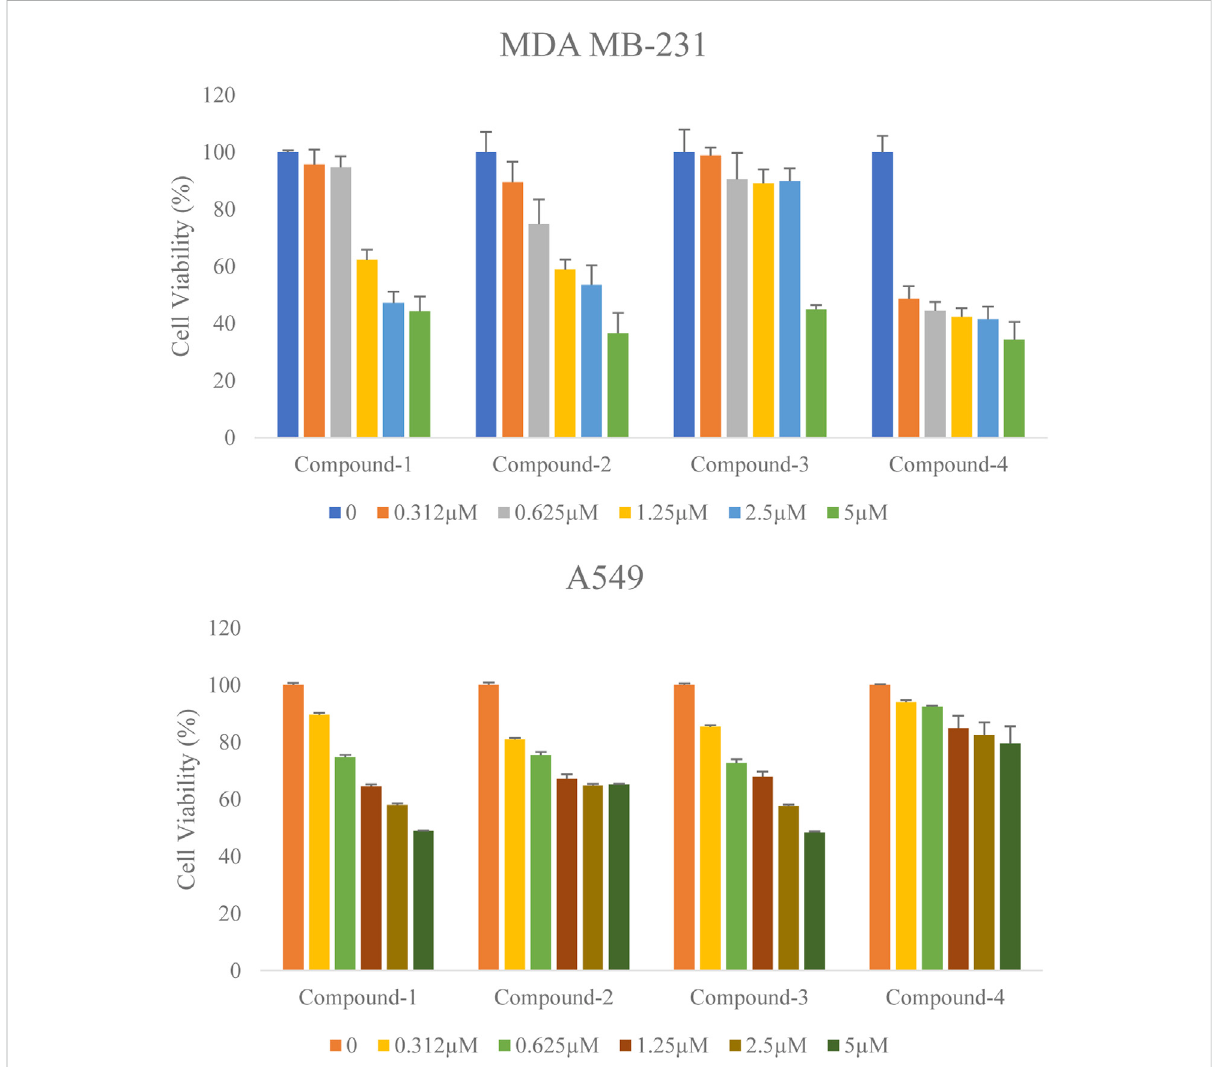
FIGURE 7 Effect of the selected compounds (Compound-1, 2, 3 and 4) on the cell viability of human breast cancer cells MDA-MB-231 and lung cancer cells A549. Both the cells were treated with various concentrations of these compounds for 72 h. Cell viability was determined by MTT assay. Percentages of viable cells were calculated by comparing treated and solvent control (DMSO) cells. Data are the mean ± S.D. of three replicates.